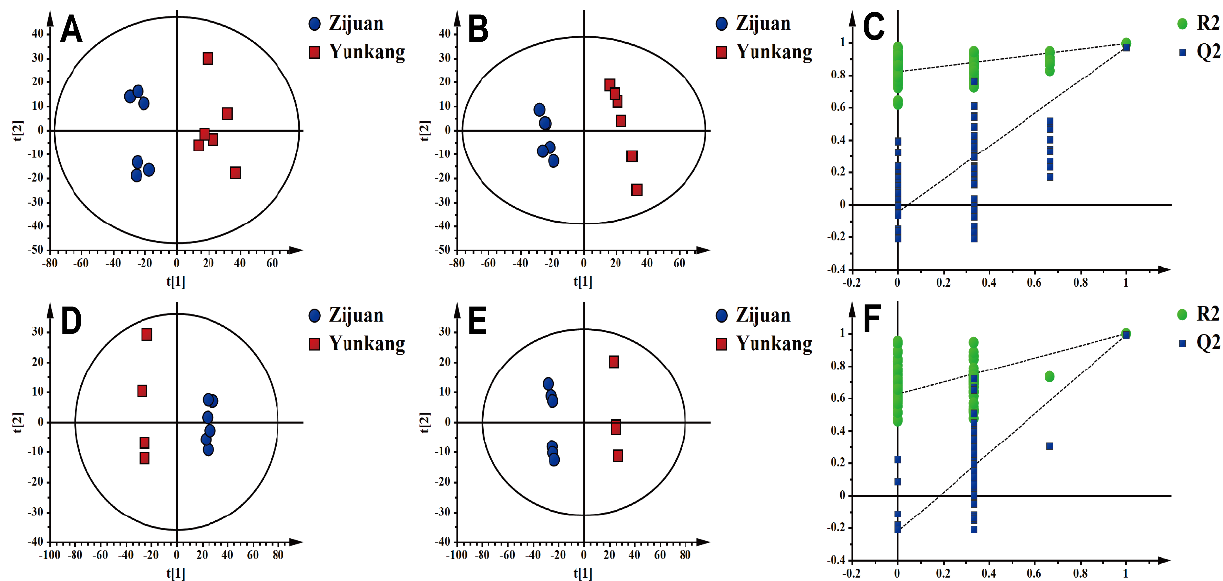
Figure 1. Multivariate statistical analysis of the differences in metabolites between Zijuan purple tea (ZJT) and Yunkang green tea (YKT). ( A ) Principal component analysis (PCA)-X score in positive ion mode (R 2 X = 0.73; Q 2 = 0.47); ( B ) partial least squares-discriminant analysis (PLS-DA) score in positive ion mode (R 2 X = 0.519; R 2 Y = 0.996; Q 2 = 0.972); ( C ) PLS-DA model validation in positive ion mode (R 2 = 0.818; Q 2 = − 0.0476); ( D ) PCA-X score in negative ion mode (R 2 X = 0.638; Q 2 = 0.506); ( E ) PLS-DA score in negative ion mode (R 2 X = 0.656; R 2 Y = 0.999; Q 2 = 0.991); ( F ) PLS-DA model validation in negative ion mode (R 2 = 0.626; Q 2 = − 0.226).